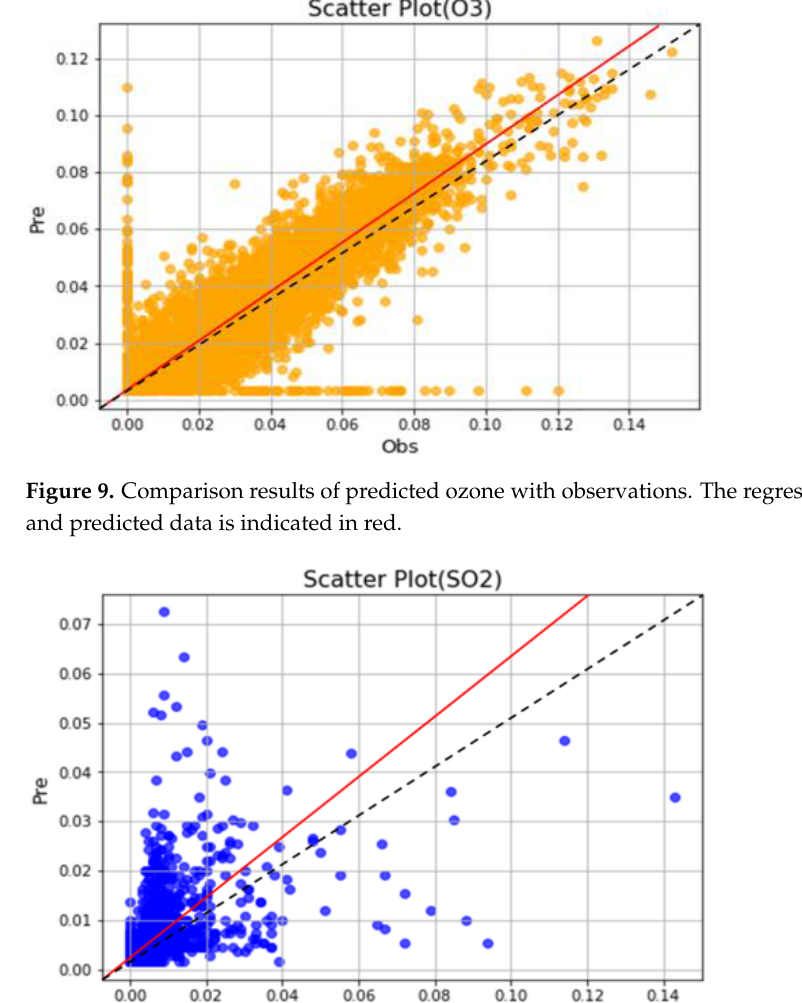
Figure 8. Comparison results of predicted fine particulate matter with observations. The regression line of observed and predicted data is indicated in red.